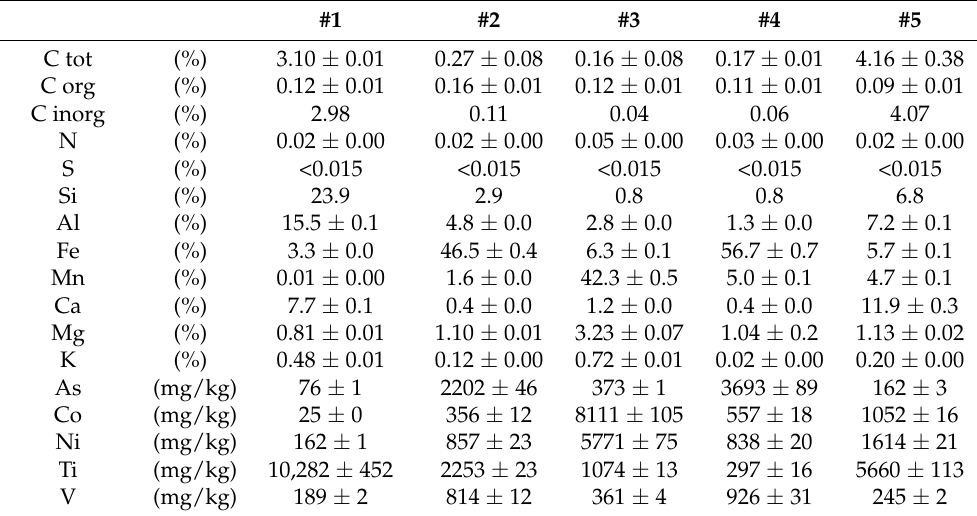
Table 1. Concentration (avg ± st. dev.) of selected major and trace elements in sediment samples. Data are from